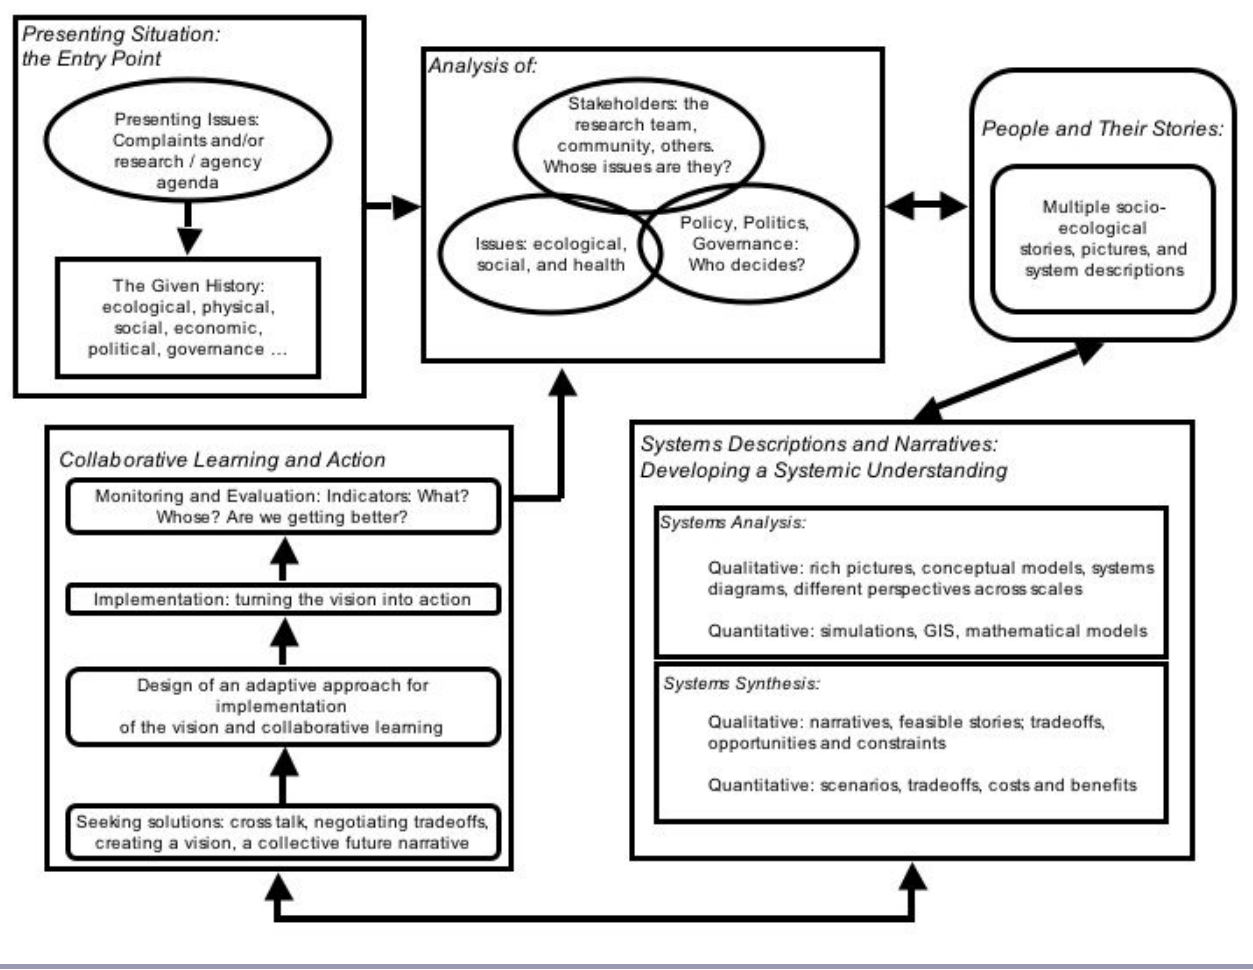
Fig. 3 . The Adaptive Methodology for Ecosystem Sustainability and Health